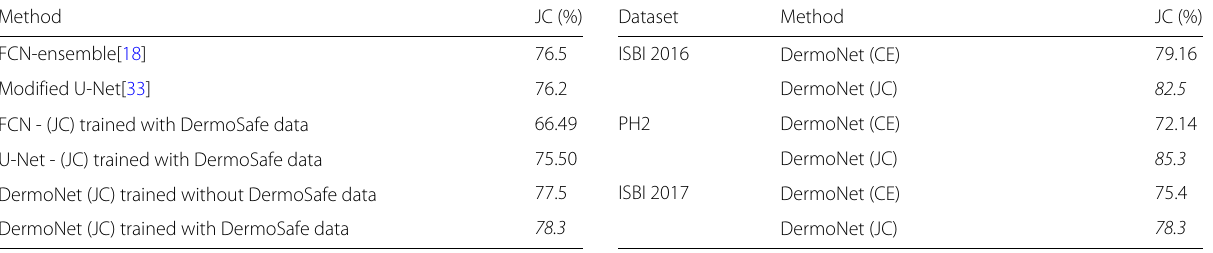
Table 6 Performance comparison between the proposed segmentation and other state-of-the-art methods on ISBI 2017 challenge test